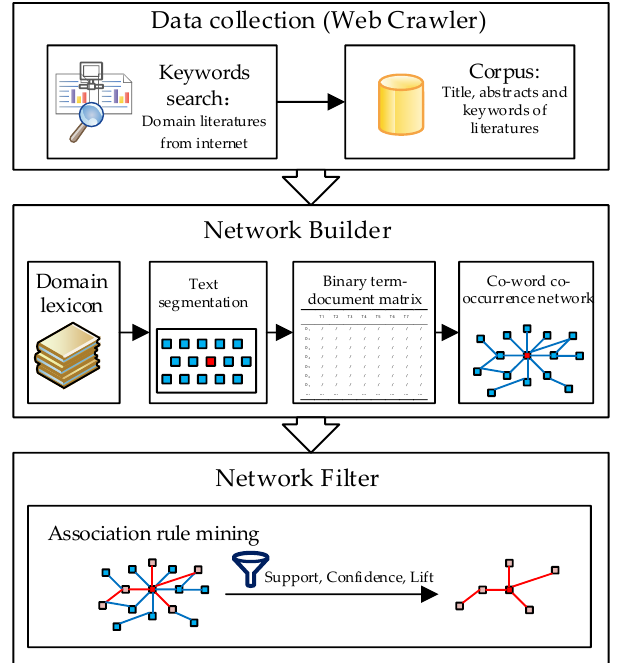
Figure 1. Architecture of the co-occurrence-based pathfinding approach.